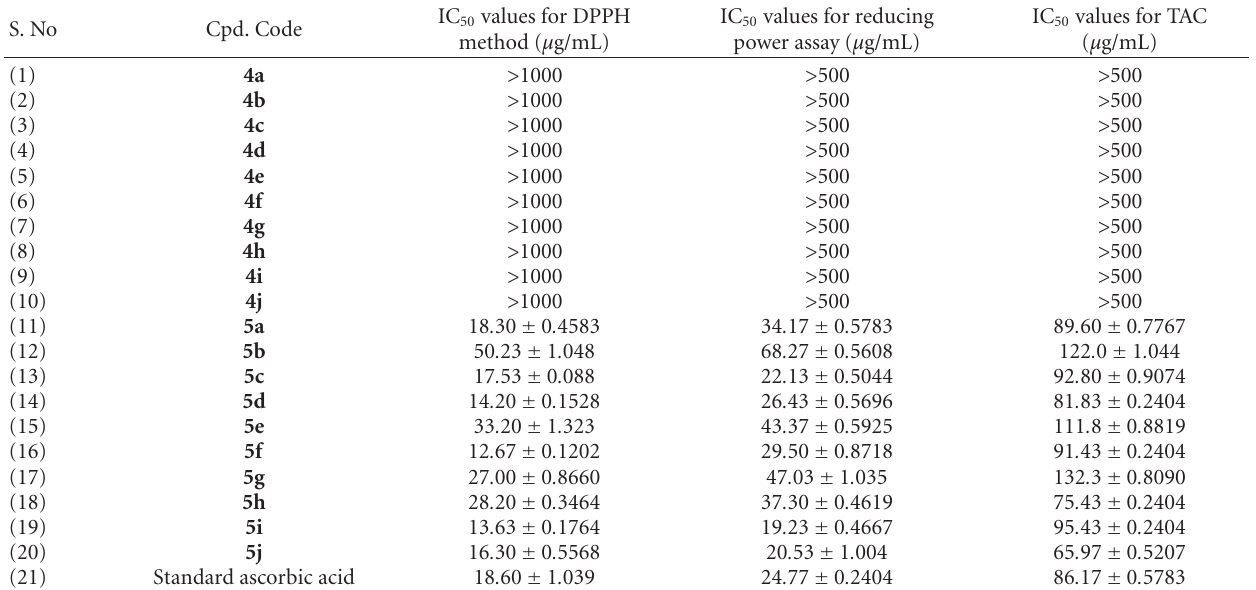
Table 1: Antioxidant activity of synthesized compounds 4a–j and 5a–j by DPPH method, reducing power assay and total antioxidant capacity method.